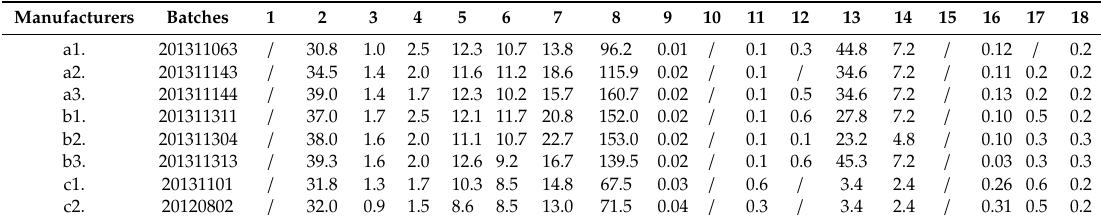
Table 3. Contents ( µ g / g) of 18 marker compounds in 8 di ff erent batches of Hu Gan tablets.